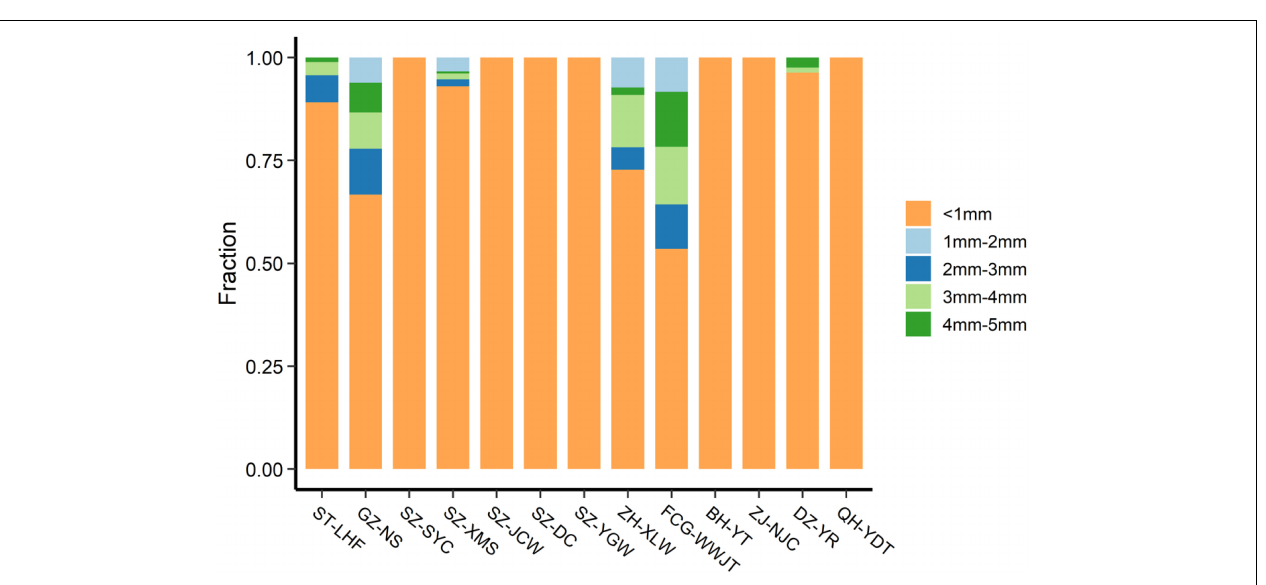
FIGURE 4 | Proportion of MPs in different size at each sampling